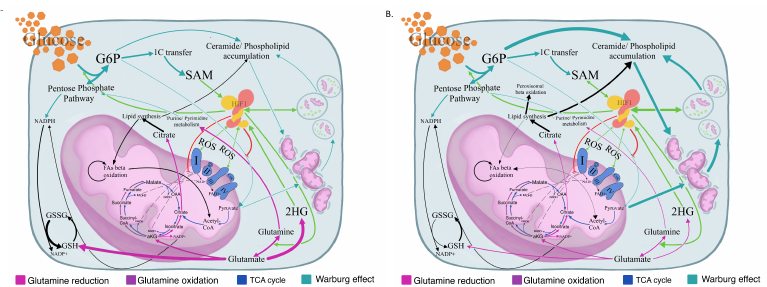
Figure 4. Schematic presentation of dysregulated metabolism of G1 and G2 MDS myeloid lineages. ( A ) Schematic presentation of the proposed metabolic profile of the G1 MDS di ff erentiating myeloid precursors with predominant glycolysis, marked ceramide and phospholipid accumulation, and blunted mitochondrial function in the field of aberrant HIF1 stabilization. Line widths reflect the grade of pathway upregulation compared to controls. ( B ) Schematic presentation of the proposed metabolic profile of the G2 MDS di ff erentiating myeloid precursors with abundant glycolysis when compared to controls, yet with an evidently improved redox status and functional mitochondrial TCA through anaplerotic reductive glutamine carboxylation. Line width reflects the extent of pathway upregulation compared to controls. SAM: S-Adenosyl-Methionine; 2-HG: 2-HydroxyGlutarate; OAA: oxaloacetate; a-Ketoglutarate: a-KG; TCA: Tricarboxylic Acid Cycle; HIF-1: Hypoxia Inducible Factor-1; Acetyl-CoA: Acetyl-Coenzyme A; and SuccinylCoA: Succinyl-Coenzyme A. Green arrows indicate enzyme upregulation by HIF-1, while the red line shows enzyme inhibition. G1: Di ff erentiating myeloid lineage cells isolated from MDS BM aspirates containing < 5% blasts. G2: Di ff erentiating myeloid lineage cells isolated from MDS BM aspirates containing ≥ 5%